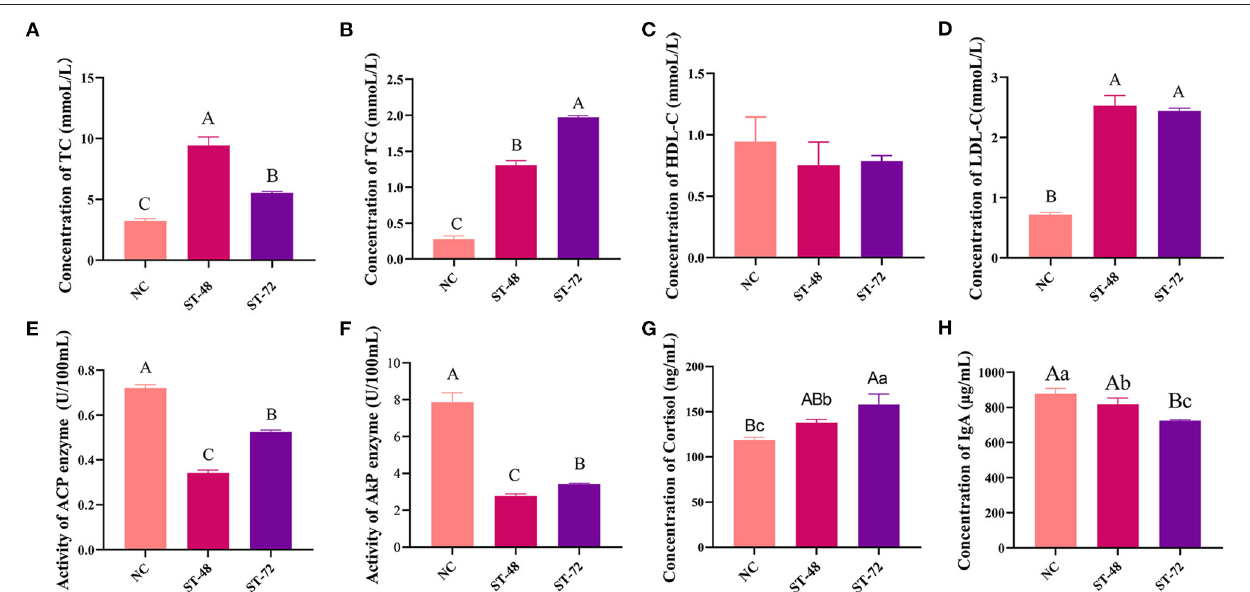
FIGURE 1 | Serum biochemical parameters of (A) total cholesterol, (B) triglycerides, (C) high-density lipoprotein cholesterol, (D) low-density lipoprotein cholesterol, (E) acid phosphatase, (F) alkaline phosphatase, (G) cortisol, and (H) IgA were measured in the starvation stress groups and normal piglets. Uppercase and lowercase letters indicate significant differences at P < 0.01 and P < 0.05, respectively, between groups. Data marked with different uppercase letters indicate significant differences ( P < 0.01), different lowercase letters represent significant differences ( P < 0.05), respectively.